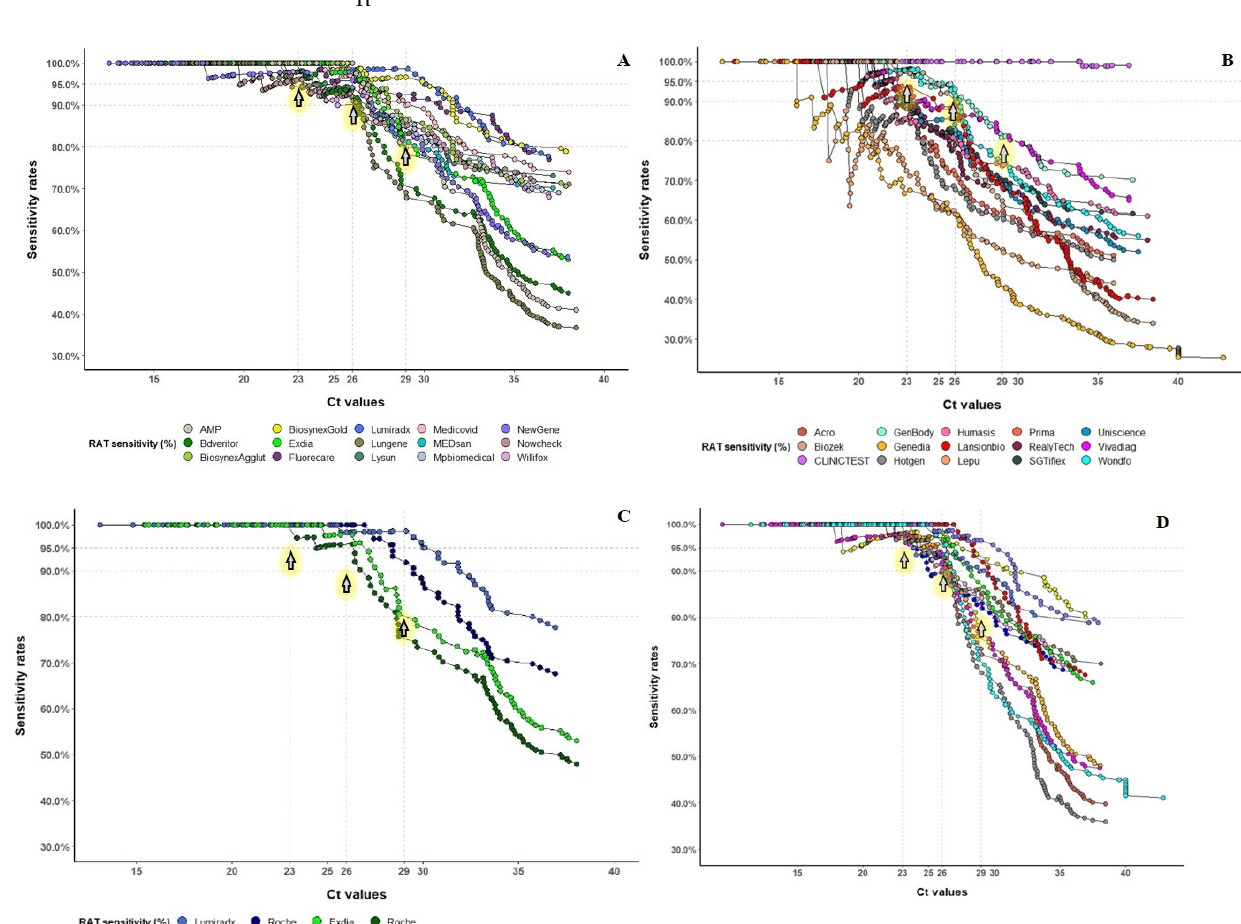
Figure 3. Comparative cumulated sensitivity curves for all rapid antigen tests (RATs) evaluated in the study. Figure 3 legend. ( A ). All RATs passing the validation criteria. ( B ). All RATs failing the validation. ( C ). RATs with an automated reader (Exdia from Precision Biosensor and LumiraDx assay from LumiraDx, Alloa) showed higher sensitivity performances compared to the internal reference (Roche). ( D ). Sensitivity curves comparing all the internal reference tests (Roche) used along each series showing the inter-laboratory and inter-series variability. RAT: rapid antigen test. On the x -axis there is the number of Ct; horizontal lines represent the Ct cut-offs considered for the validation criteria. Horizontal dotted lines and the three arrows represent the threshold of sensitivity rates to be considered for validation at different Ct cut-offs. Table 2. Sensitivity and specificity rates of antigen tests failing the validation, stratified according to the viral load. Numbers in brackets indicate the 95% confidence